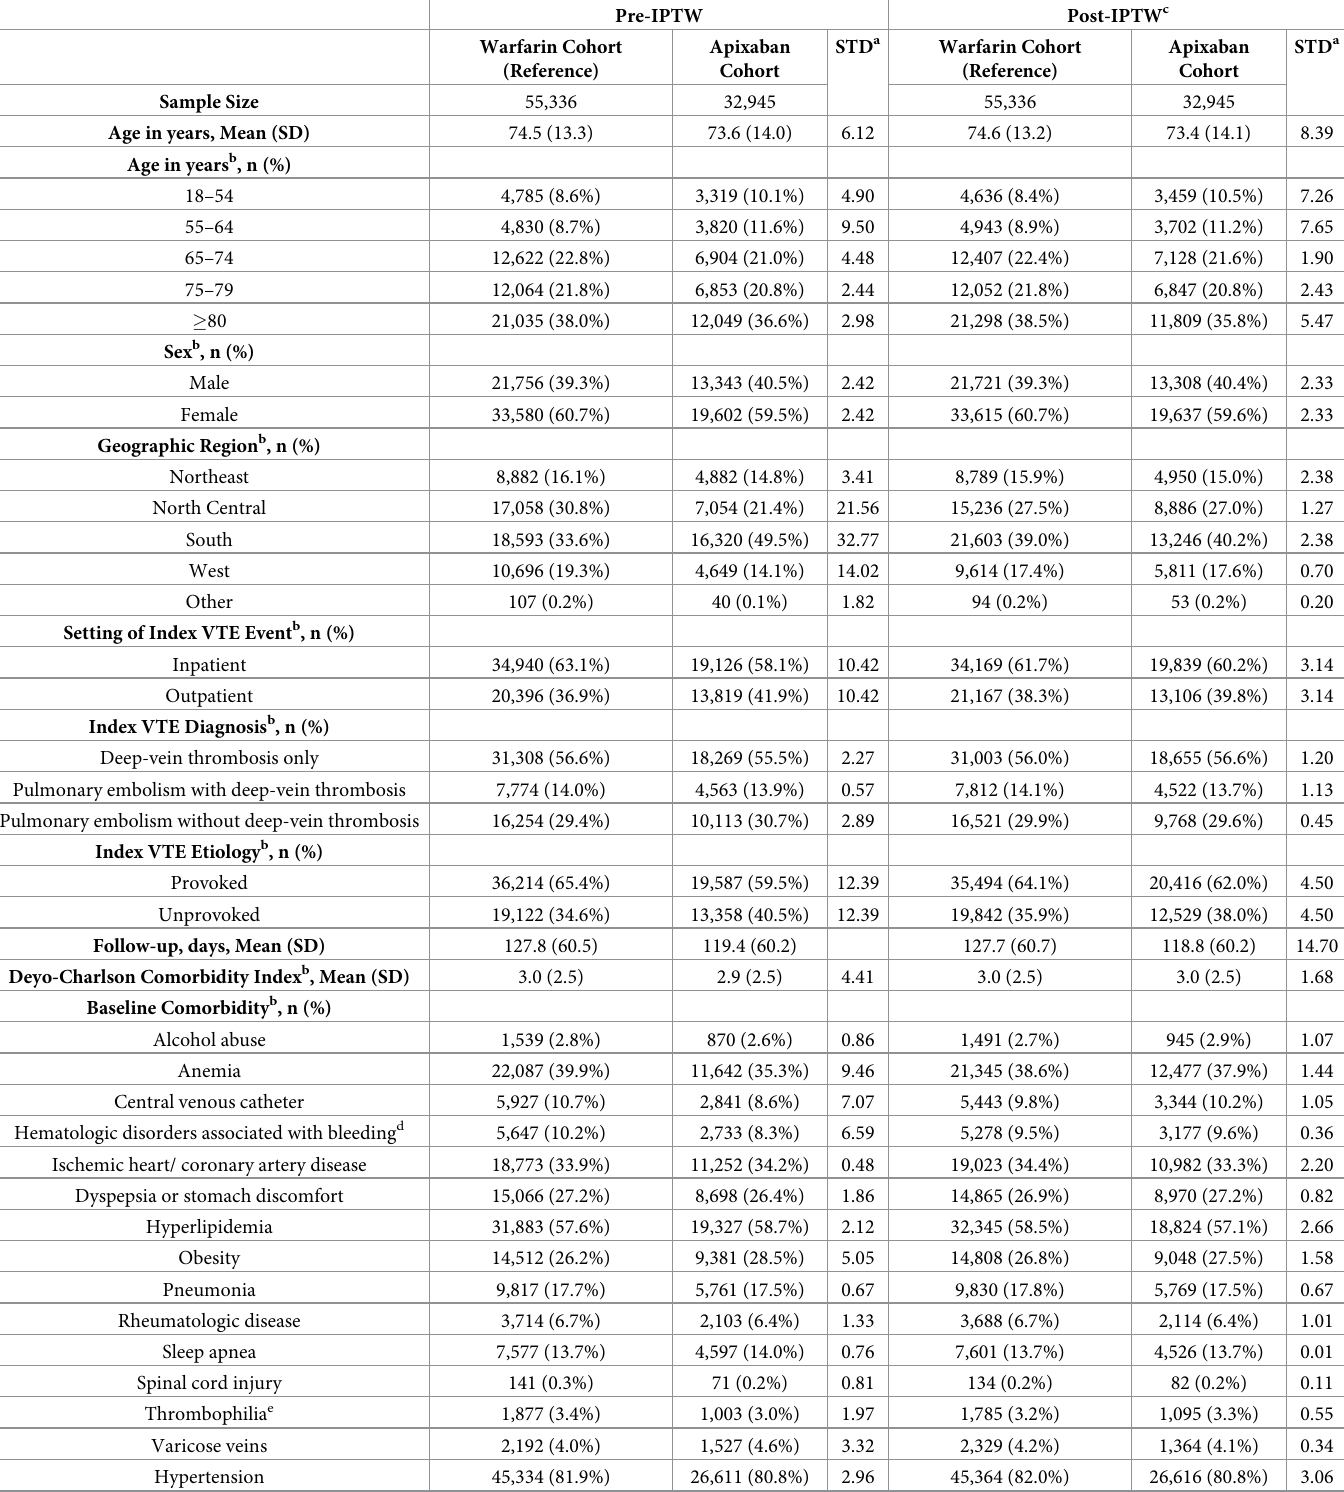
Table 2. Descriptive pre- and post-IPTW baseline characteristics among VTE patients at a high risk of bleeding that initiated apixaban vs